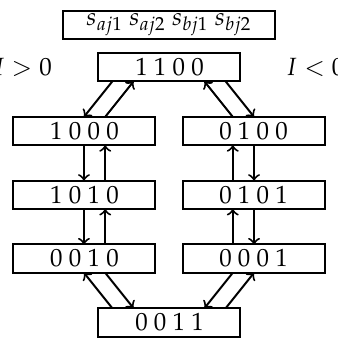
Figure 4. Four-step current commutation